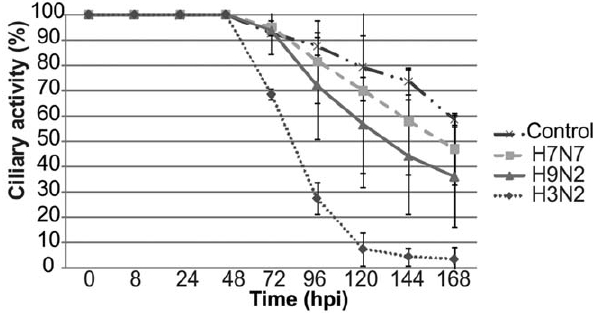
Figure 6. Infection of swine PCLS by porcine and avian influenza viruses evaluated by ciliary activity. PCLS were mock- infected or infected by porcine H3N2, avian H9N2, or avian H7N7 virus. Up to seven days post infection, PCLS were analyzed for ciliary activity at daily intervals.